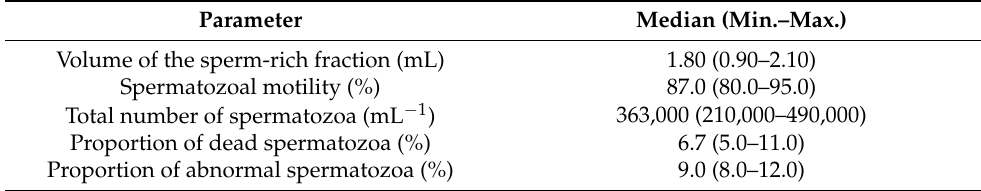
Table 1. Results of evaluation of semen samples from dogs into the study.